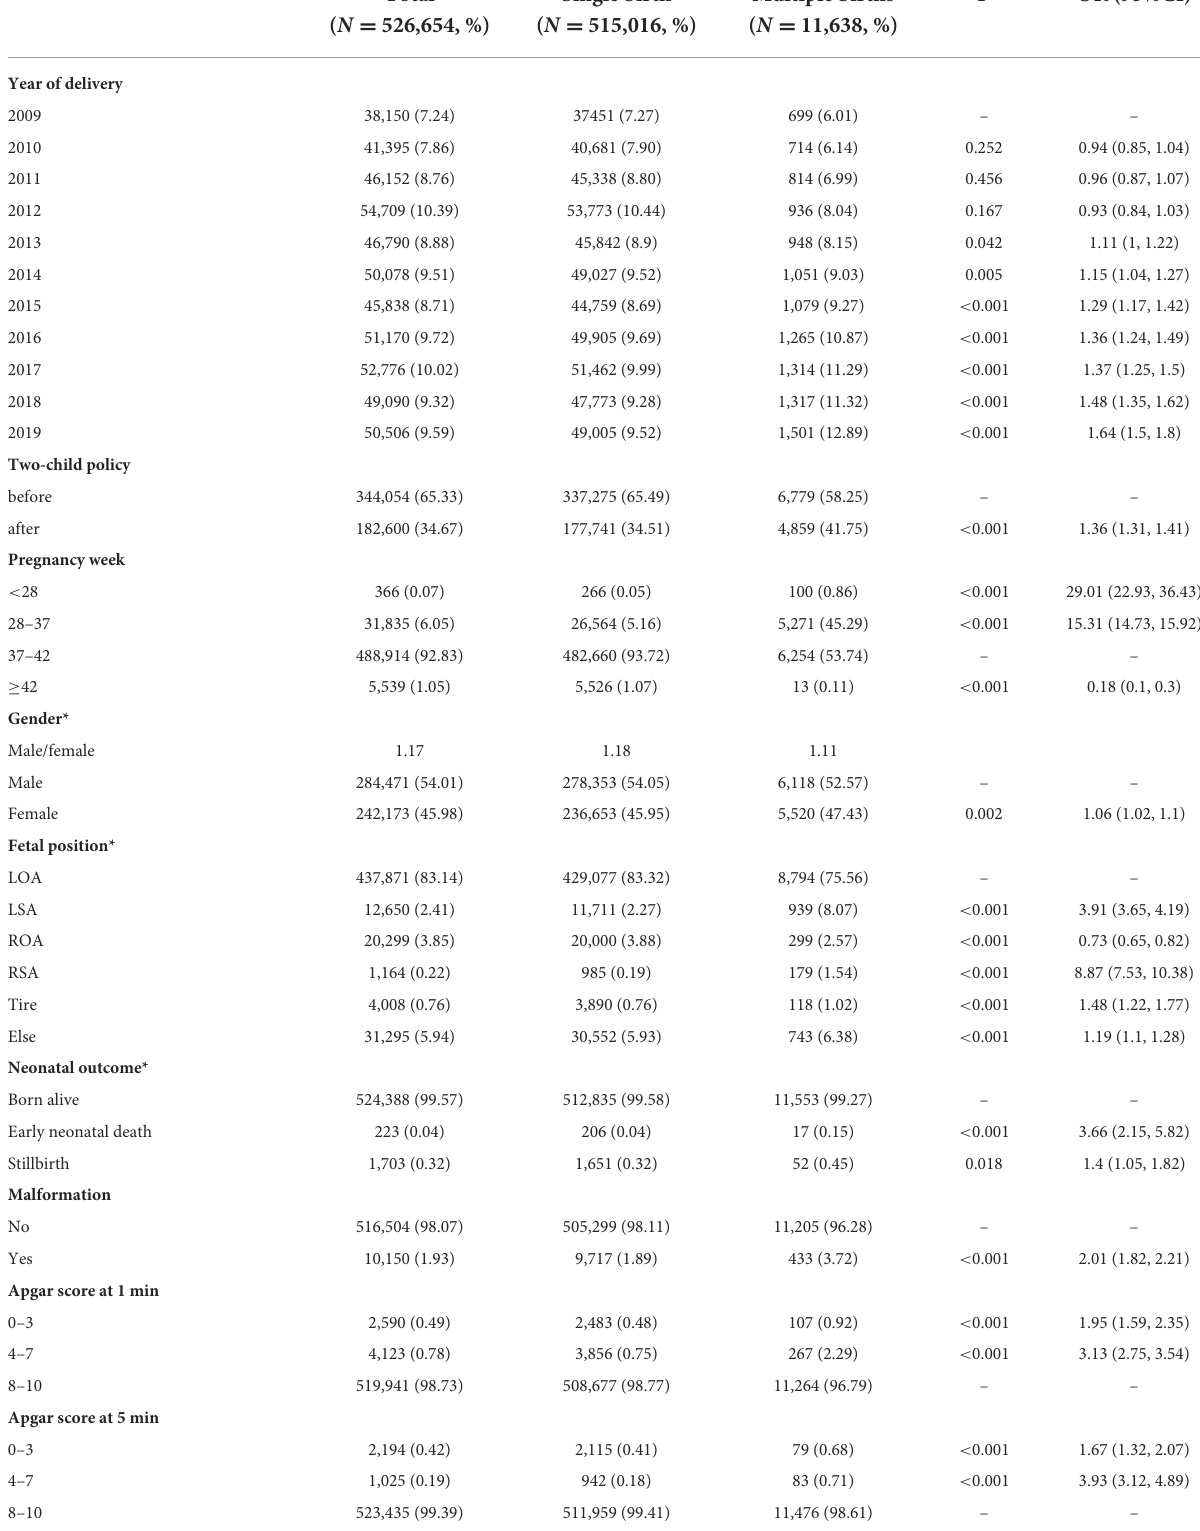
TABLE 2 Monofactor analysis for newborns from multiple births and singleton in Baoan Shenzhen,